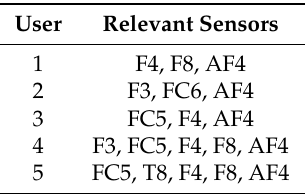
Table 2. Relevant electrodes for each participant in Dataset